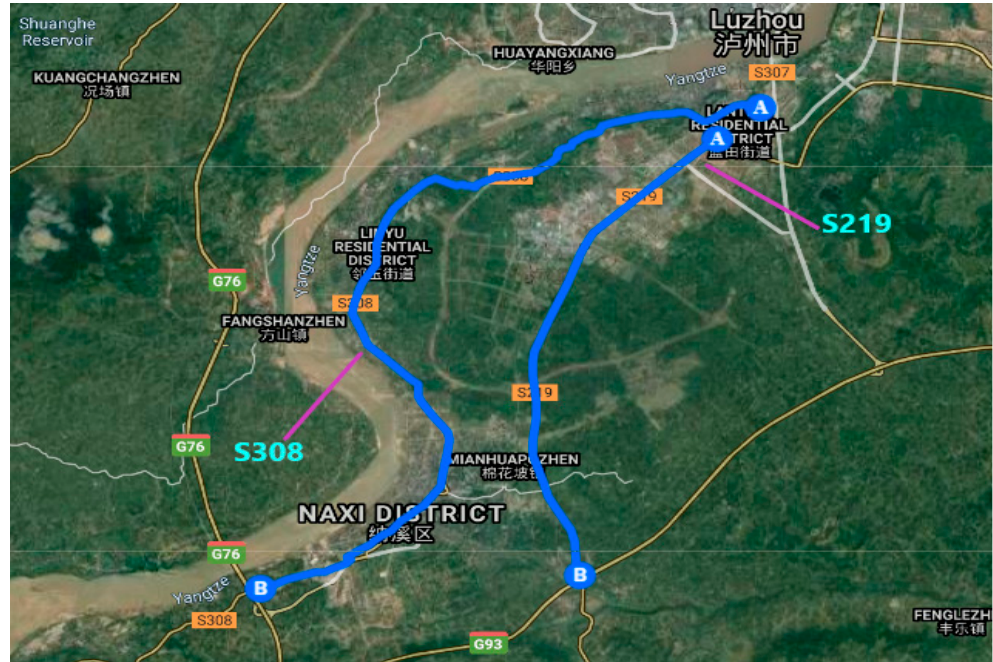
Figure 1. Locations of S219 and S308 in the study area (from Google Maps).